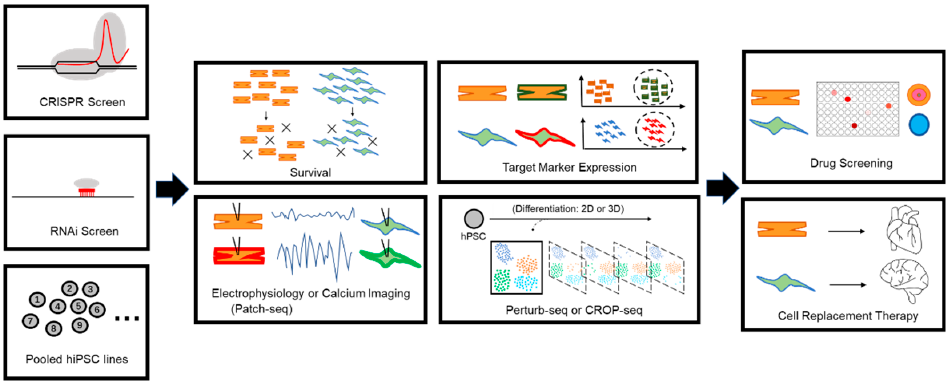
Figure 3. Schematic for potential workflows to investigate shared genetic variants in CHD and